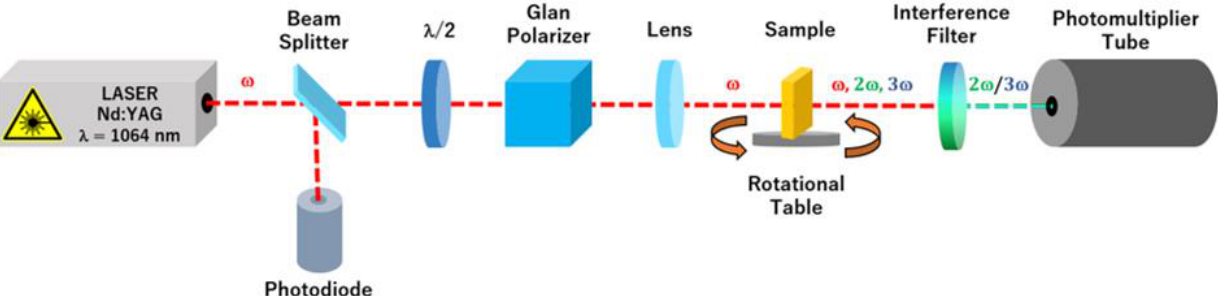
Figure 2. Experimental setup for SHG and THG measurement. After passing the sample, the laser beam was cut off with an interference filter that does not pass radiation at this wavelength. To collect the SHG signal, a 532 nm filter was used, whereas a 355 nm filter was used for the THG signal.